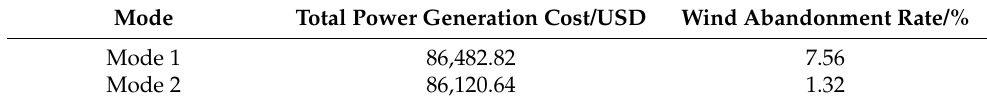
Table 3. The wind abandonment rates and the total power generation costs in the two modes.